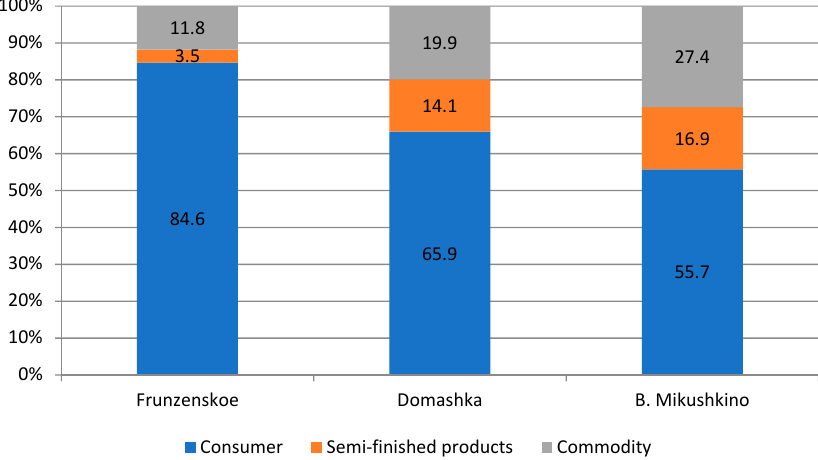
Figure 8. Comparison of private household plots by equipment in 2014–2018.